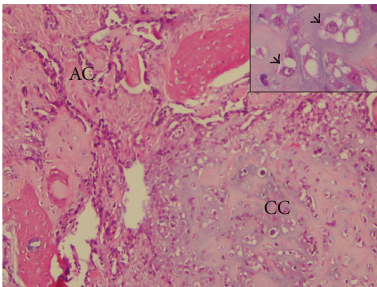
Figure 4: Anatomo-pathologic examination of the primary lesion (ethmoidal samples): the two tumoral contingents are present at the outset: adenocarcinoma (AC) is in contact with chondroid chordoma (CC). Physaliphorous cells are visible ( → ). Their nuclei are eccentric, with prominent nucleoli and cytoplasmic vacuoles of mucoid